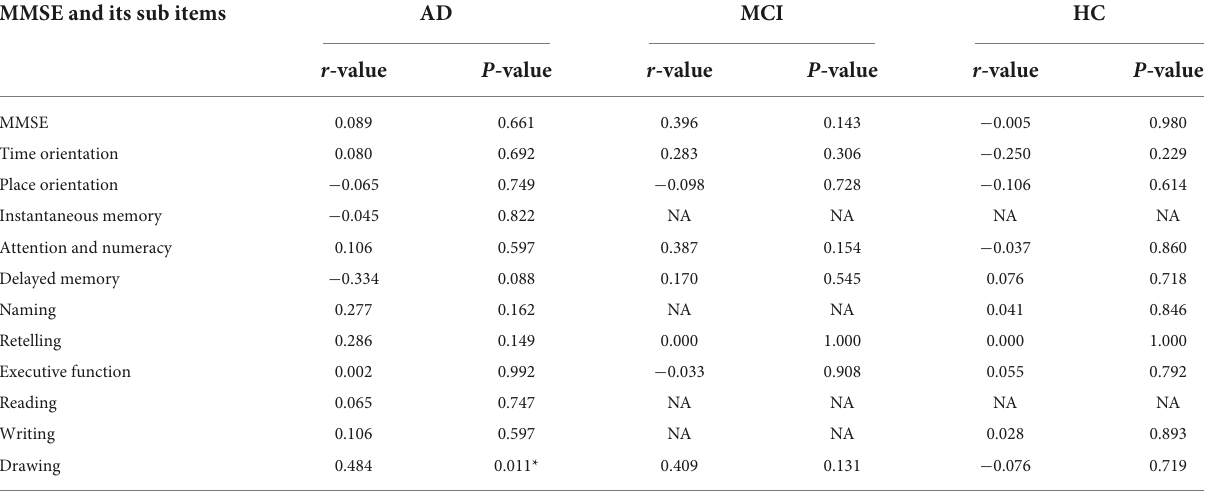
TABLE 3 Correlation analysis between locus coeruleus signal contrast ratios (LC-CRs) and Mini-Mental State Examination (MMSE) including its sub items. MMSE and its sub